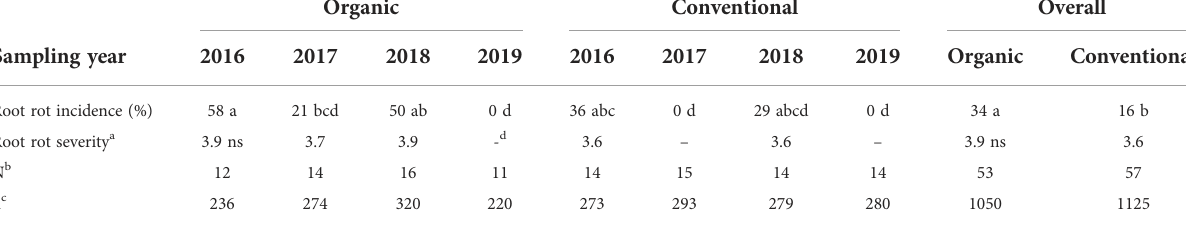
TABLE 3 Mean root rot incidence (%) and root rot severity ratings (DSR) of faba bean fi elds in Germany, 2016-2019. Organic